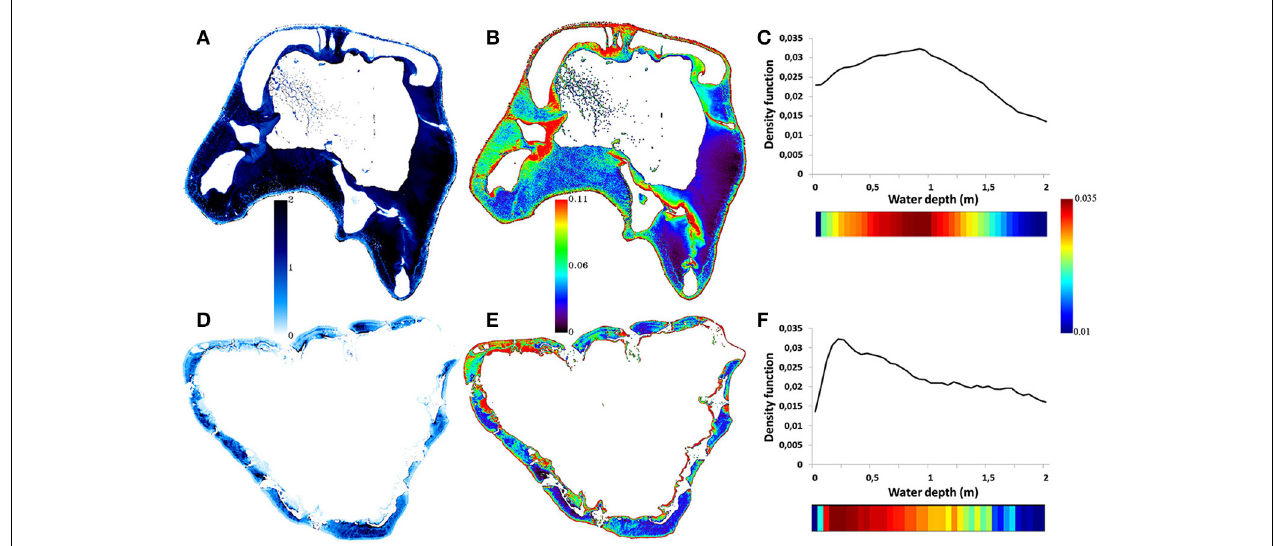
FIGURE 4 | Digital models of the water depth and reflectance of the “red edge” band compounded with the water depth in respect to the density function of the reflectance of the “red edge” band related to Tetiaroa (A–C), and to Moorea (D–F). The water depth is positively correlated with the darkness of the blue gradient (0–2m). The